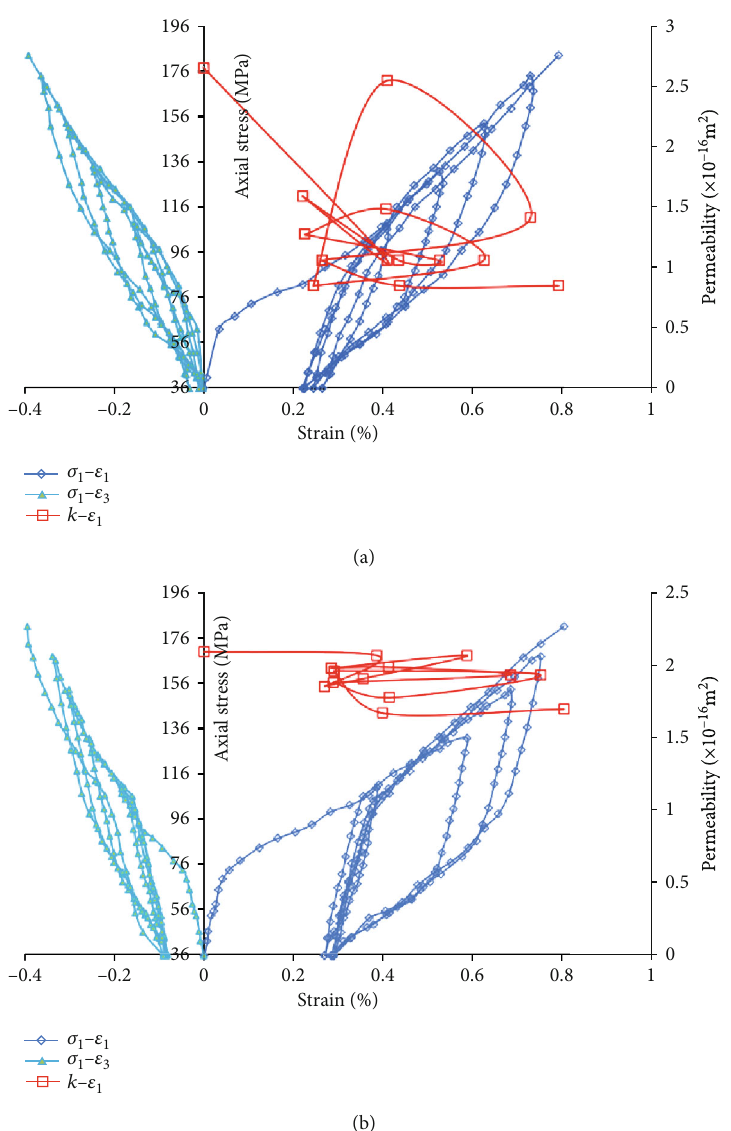
Figure 7: Stress-strain and permeability-axial strain curves for fractured sandstones under axial cyclic loading-unloading: (a) single-fracture sandstone; (b) double-fracture